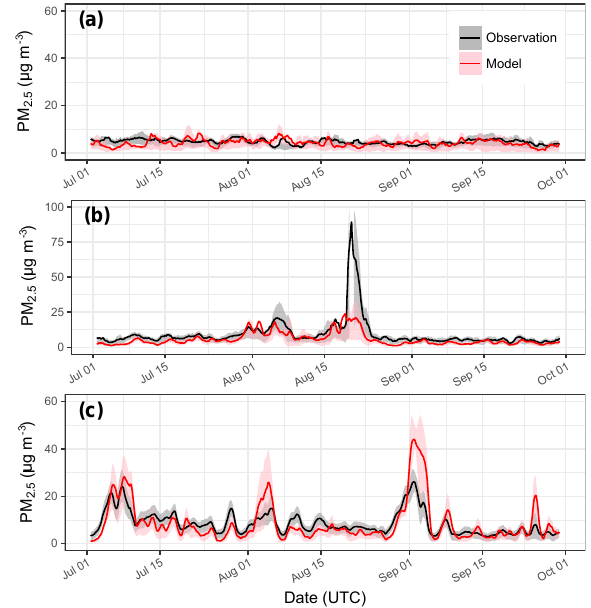
Figure 4. Regional averaged O 3 time series (24h running mean), modelled and observed: (a) northern, (b) southwestern, (c) south- eastern; shades indicate 1st–3rd quartile range.